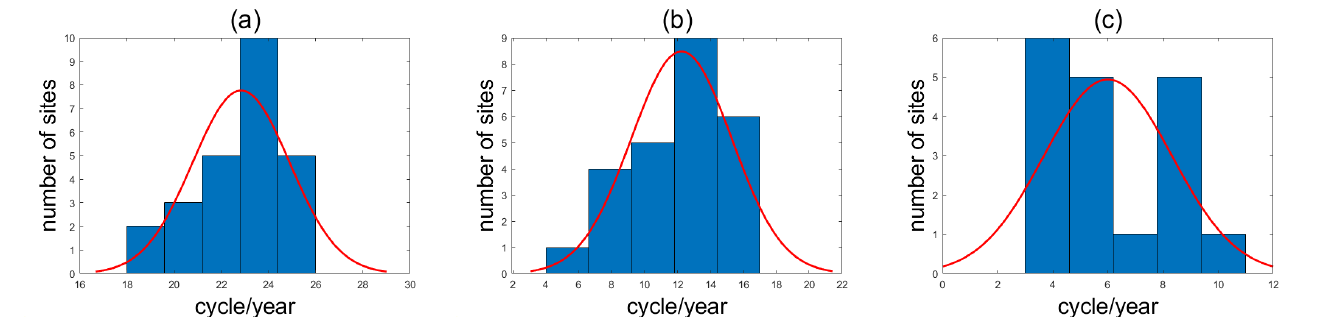
Figure 7. Frequency histograms of the first, second and third cycles of annual evaporation changes in the Yangtze River Basin, ( a ) first cycle, ( b ) second cycle and ( c ) third cycle.